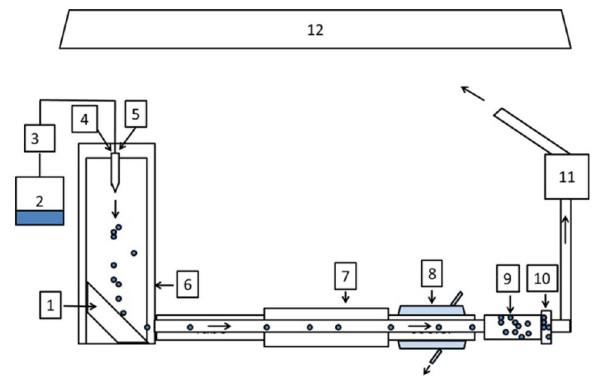
Fig. 2 Schematic illustration of spray drying setup developed at the Research Institutes of Sweden (RISE). 1. PVC panel; 2. reactants; 3. pump; 4. N gas; 5. nozzle; 6. protective tube; 7. furnace; 8. water 2 cooler; 9. particle collector; 10. filter bag; 11. exhaust pump; 12.